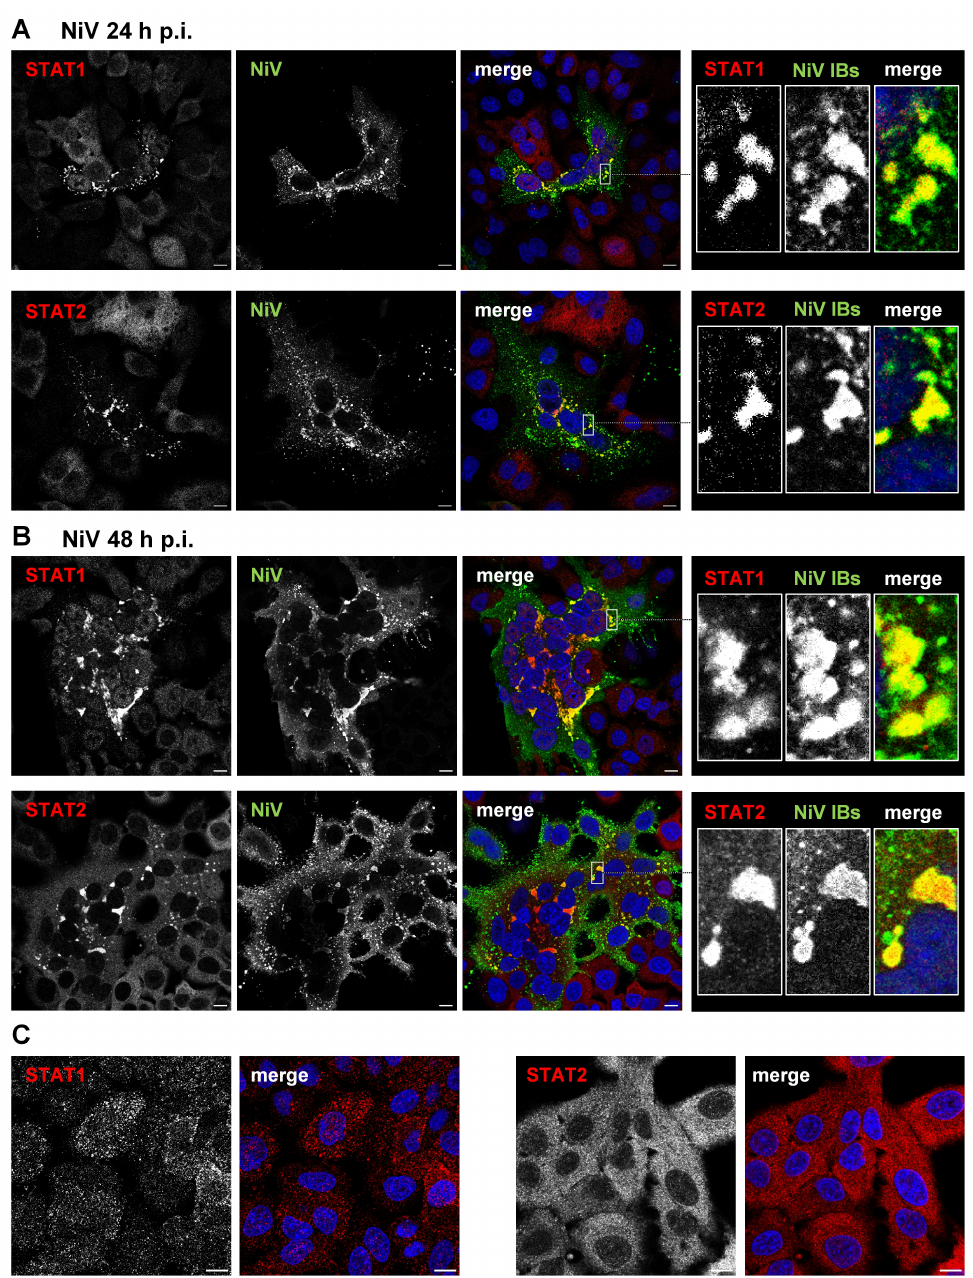
Figure 1. STAT1 and STAT2 accumulate in cytosolic IBs formed in NiV-infected cells. A549 cells were infected with NiV at an MOI of 10. At 24 h p.i. ( A ) or 48 h p.i. ( B ), cells were fixed with PFA and permeabilized with Triton X-100. Endogenous STAT1 and STAT2 were stained with specific antibodies (red) and NiV-positive syncytia with IBs were visualized with a NiV N/P specific antiserum (green). Nuclei were counterstained with DAPI (blue). The single-channel greyscale images of the labeled proteins as well as the colorized merged images are shown. Boxed areas are displayed in a higher magnification in the right panels. ( C ) STAT1 and STAT2 distribution in non-infected A549 cells is shown. Scale bars, 10 µ